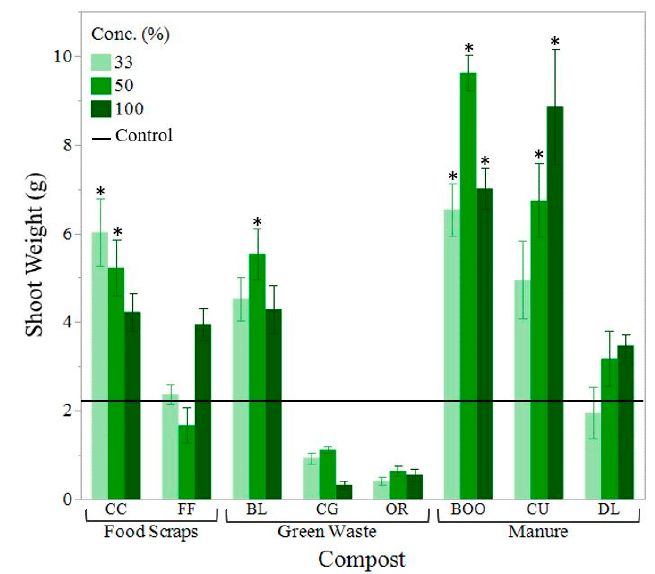
Figure 3. Mean bean plant dry shoot weight in grams by compost type. Compost concentration of the growing media shown from dark to light (100%, 50%, 33% compost). Horizontal solid black line indicates the mean shoot weight of the control (soil). Error bars denote standard error (n = 6). Stars (*) indicate significant difference from the control ( α = 0.05).